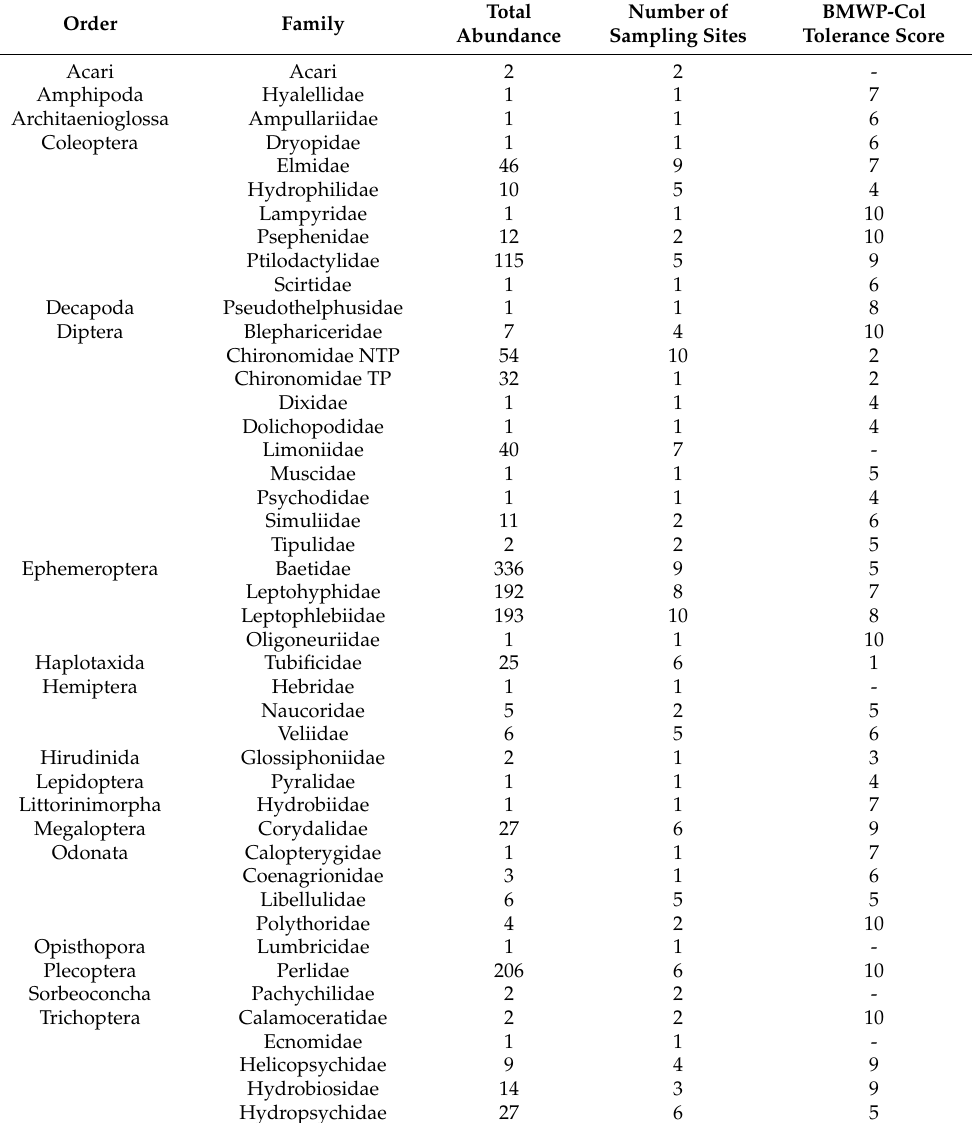
Table A3. List of encountered taxa with their total abundance in the basins, number of sampling sites where they were found, and their tolerance scores based on BMWP-Col by Alvarez